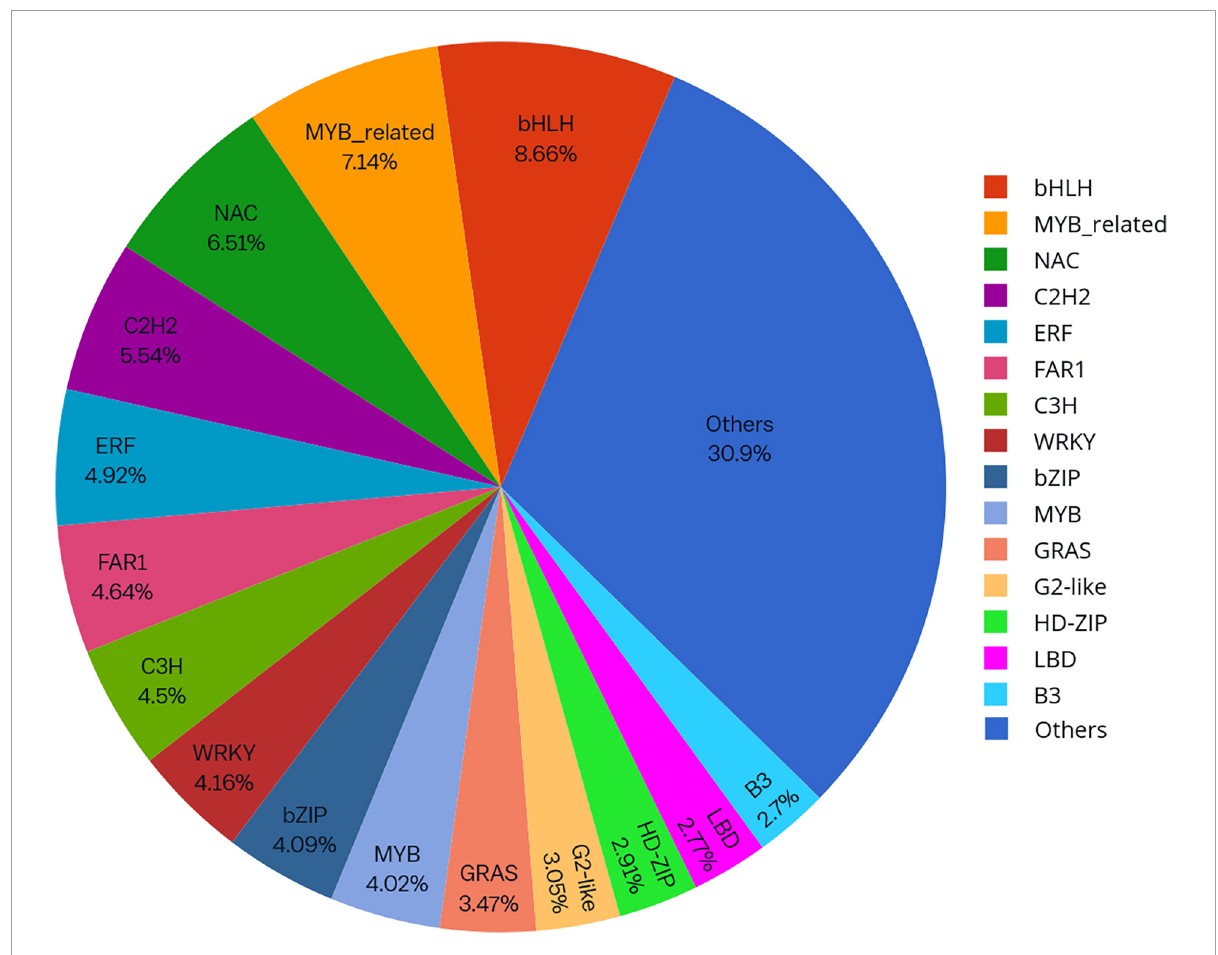
FIGURE7 Distribution of top transcription factors (TFs) families identified in M. acuminata.